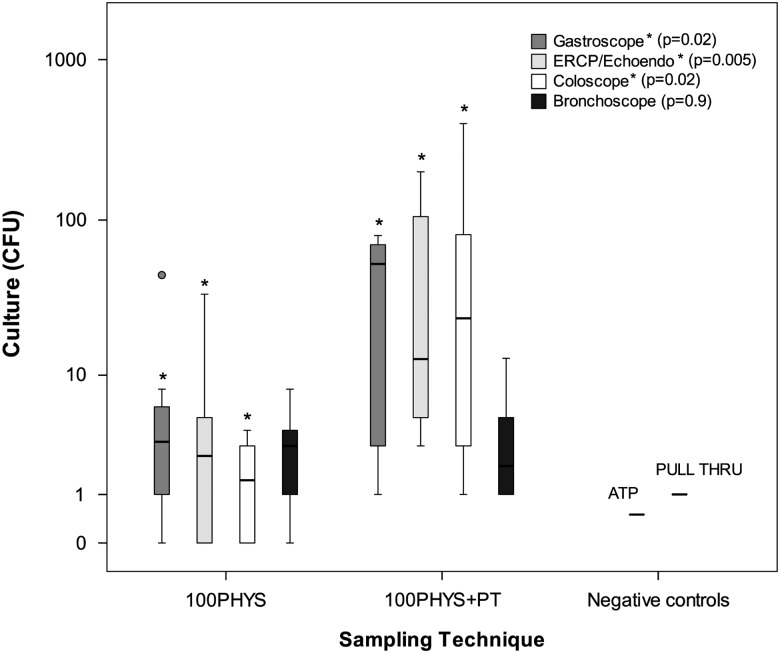
Culture results obtained from endoscopic samples using the 100PHYS and 100PHYS+PT
sampling methods and the results of negative controls. Culture results were obtained
from TSA agars with filter. Note: 100PHYS, flushing with 100 mL sterile
physiological saline; 100PHYS+PT, flush-brush-flush using 100 mL sterile
physiological saline and a PULL THRU brush; CFU, colony-forming units; ATP,
adenosine triphosphate; *Statistically significant differences between mean yield of
culture using 100PHYS and 100PHYS+PT sampling methods for different types of
endoscopes. P values are shown.